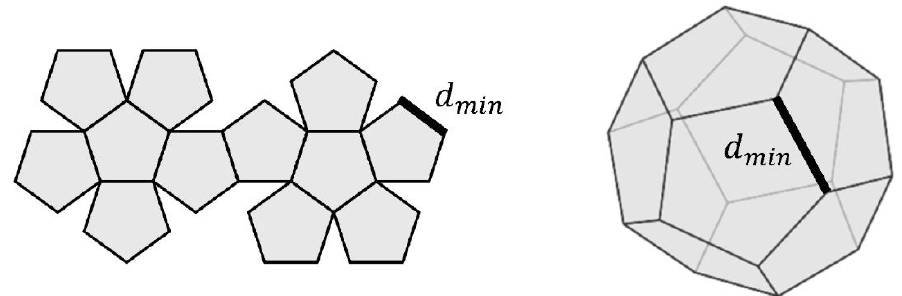
Figure 6. Importance value I AB (circles) when nodes A and B are compared under the number of hops criterion. Data: d max = 10 km, d min = 0.5 km, 𝛿 = 1.